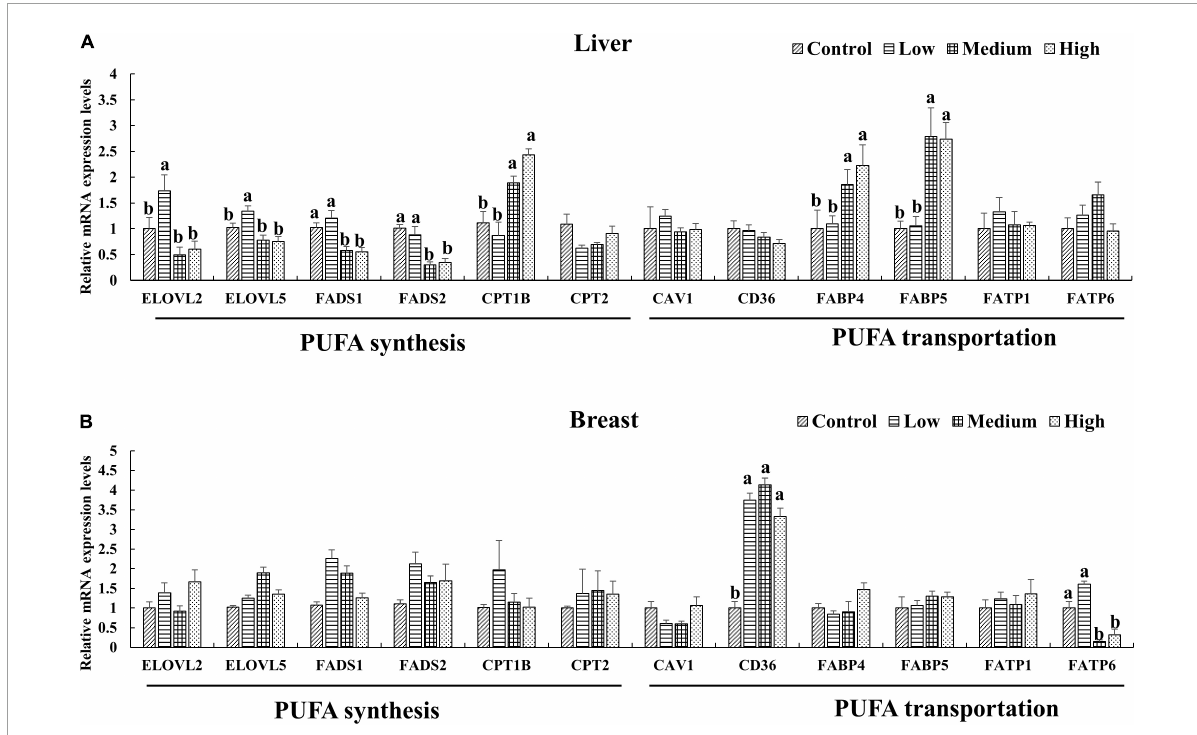
FIGURE4 Expression of key genes verified by RT-qPCR in liver (A) and breast muscle (B) . Mean values marked with different letters in the same column indicate significant differences ( P < 0.05, n =